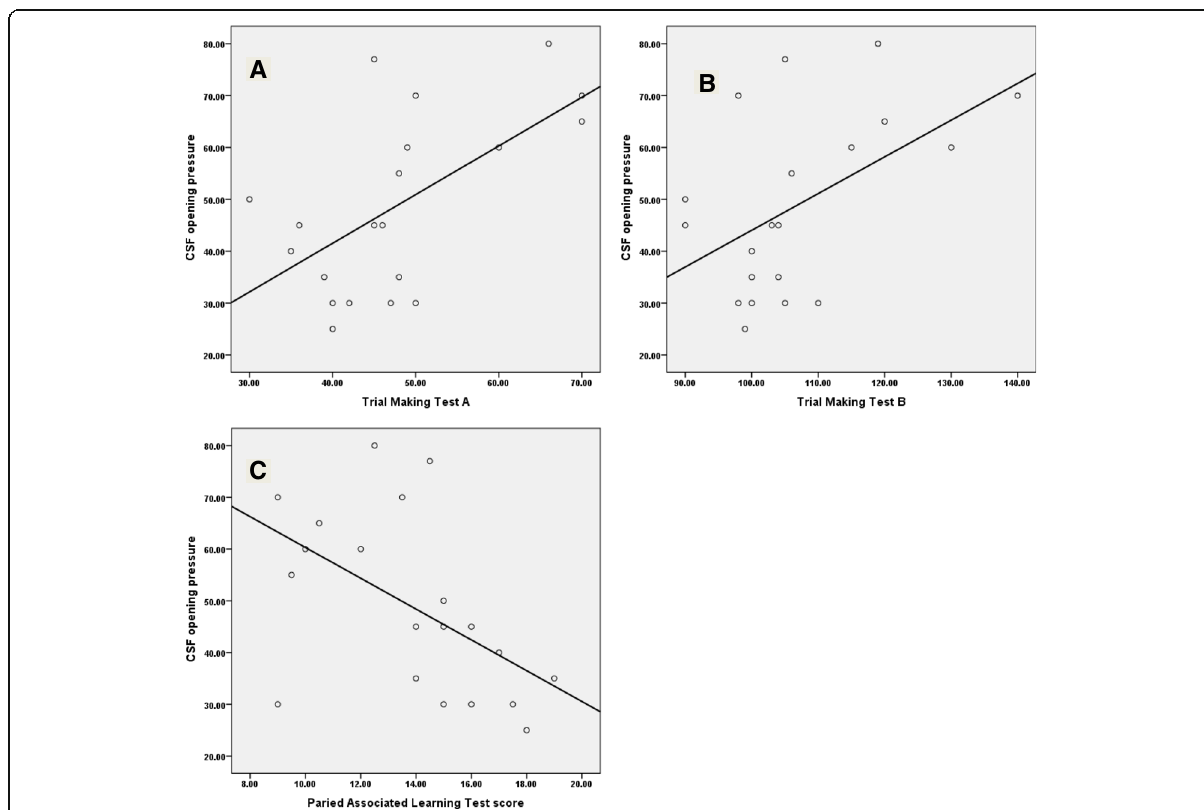
Fig. 2 Correlation between CSF opening pressure and different psychometric tests. a Represents the correlation between CSF opening pressure and Trail making test A (TMT A) b Represents the correlation between CSF opening pressure and Trail making test B (TMT B). c Represents the correlation between CSF opening pressure and Paired Associate Learning Test